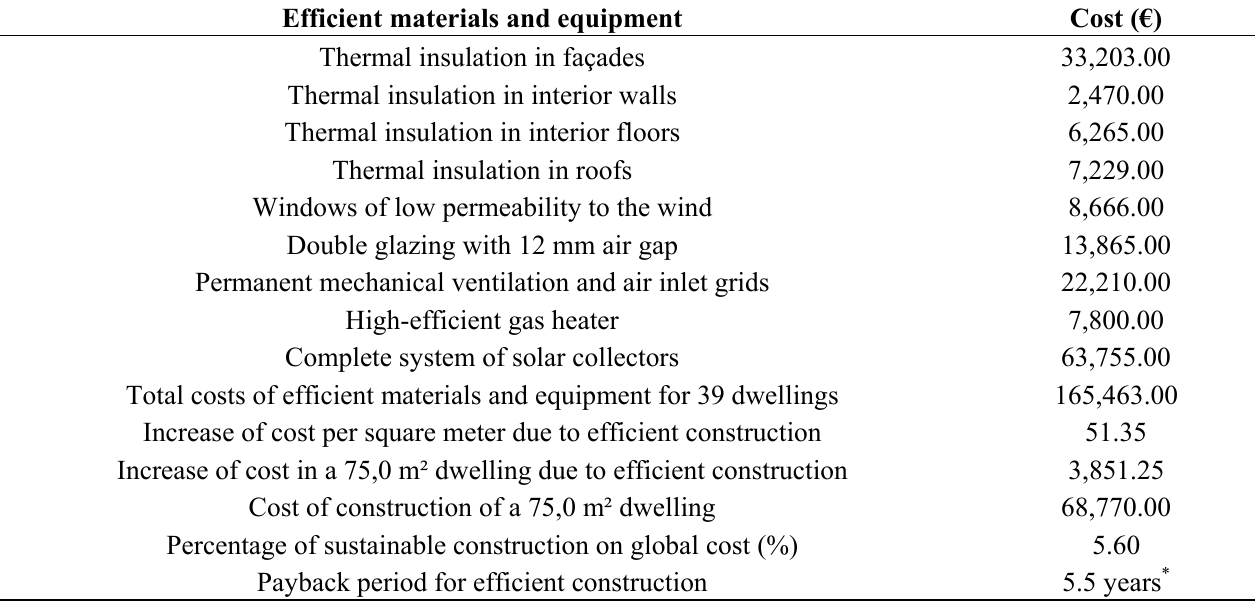
Table 12. Cost of efficient materials and equipment of Madalena project and payback period for sustainable construction with standard comfort energy consumptions (39 dwellings).